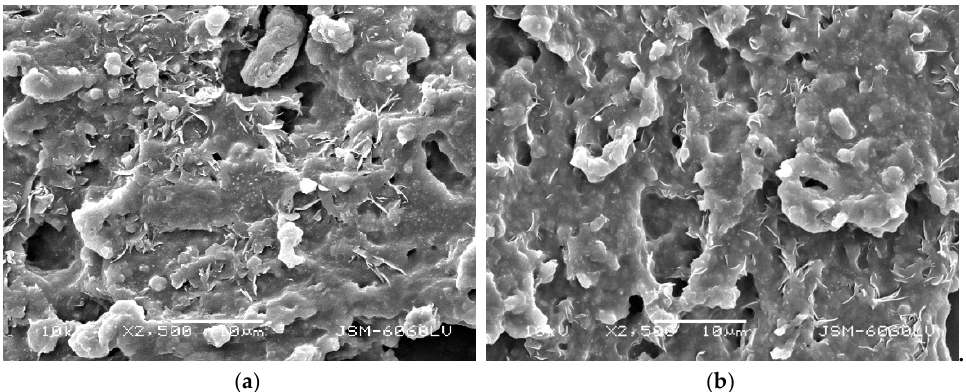
Figure 16. SEM images of EPDM plate samples after swelling in IPA: ( a ) 10× UV treatment, ( b ) 30× UV treatment.